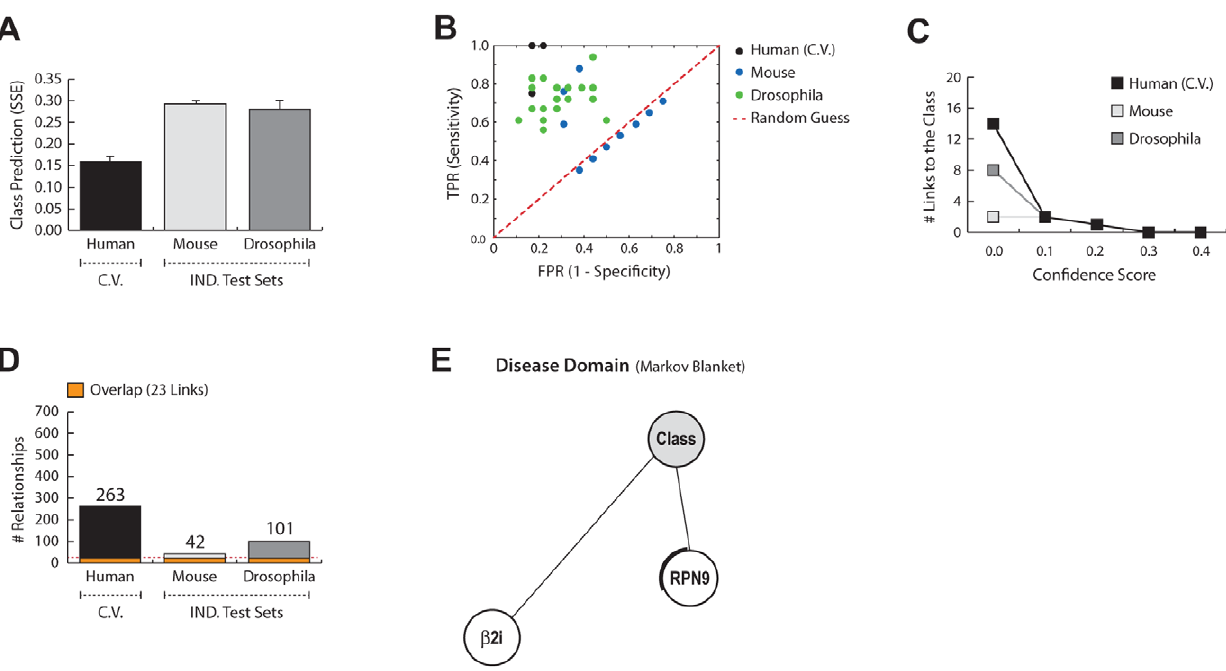
Figure 3. Performance of the naı¨ve Dandelion algorithm on constructing disease networks that are learnt on human and evaluated on human, mouse and Drosophila datasets. A ) The average Sum of Squared Error (SSE) for prediction of the disease phenotype (OPMD vs. control) given the gene expression profiles within the disease networks learnt on human. The cross-validation set which is used during the training phase is depicted by C.V. and the independent test sets are grouped as IND. Test Sets . B ) ROC space demonstrates the relative sensitivity and specificity of the generated networks in predicting the disease phenotype. The results from random expectations are illustrated by the red dash-line. C ) Number of relationships between genes and the class node, after applying confidence thresholds, are depicted in line per species. D ) The number of links found after interspecies translation and optimization of the disease networks within each species. The orange section, separated by red dash- line, represents the number of links that can be found in all species with the confidence threshold of 0.1. E ) The interspecies disease domain is generated according to the Markov blanket criteria, after applying the confidence threshold of 0.1.